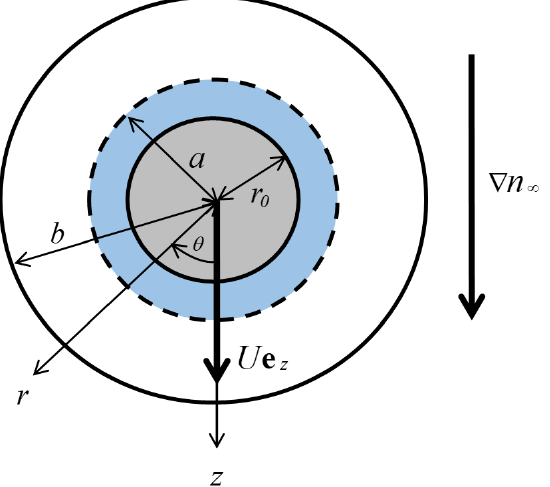
Figure 1. Geometric sketch for the diffusiophoresis of a charged soft sphere in a unit cell.